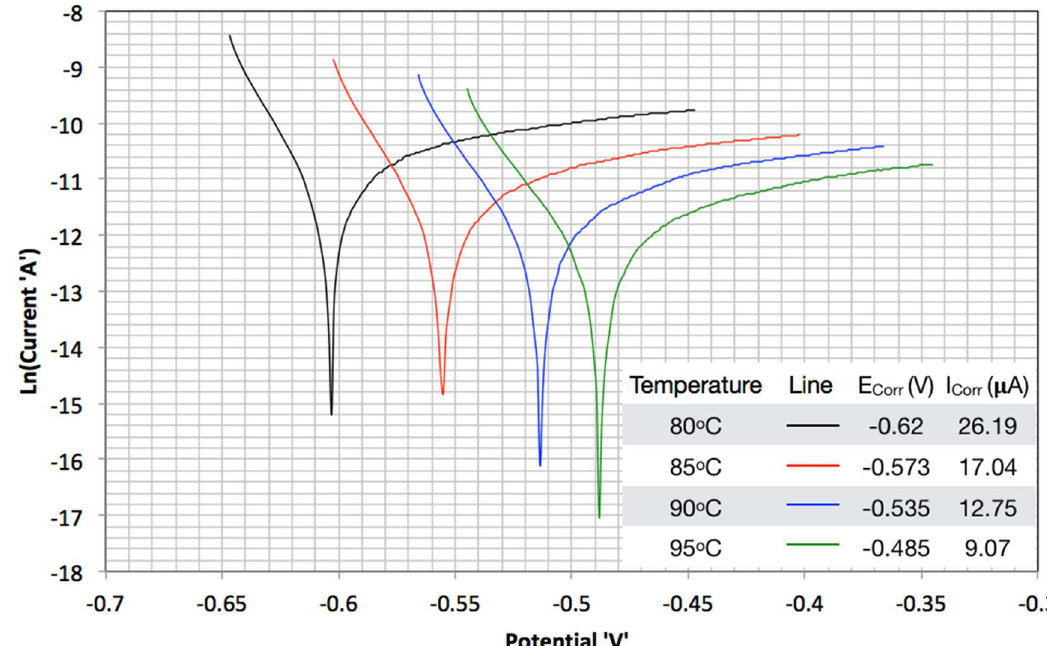
Figure 6. Tafel curves of [bmim][MS] and 20% MDEA without CO 2 at different temperatures. Scan rate = 1 mV/s. Fitted results for corrosion rates and potential are provided in the table.